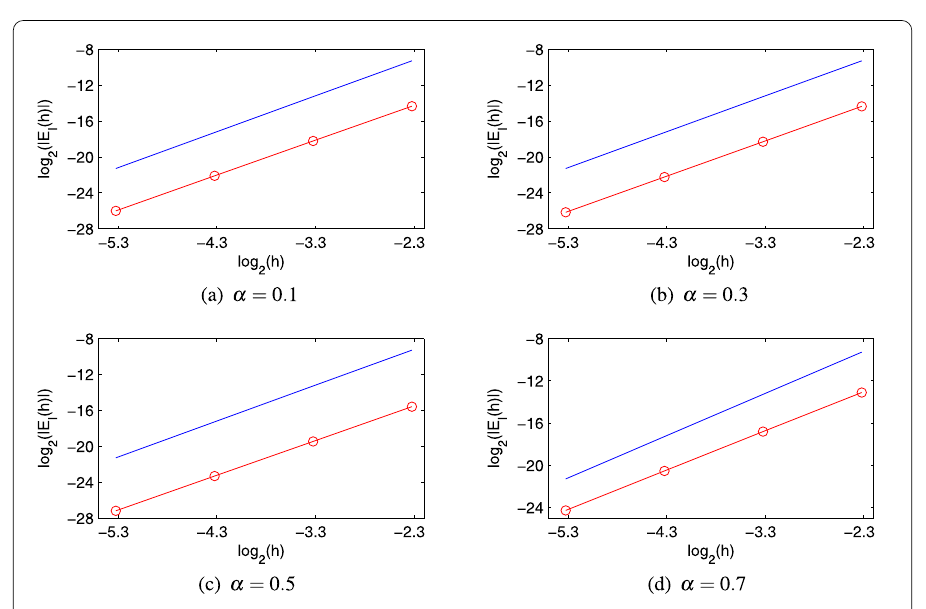
Figure 7 The experimentally determined orders of convergence for algorithm I at t = 1 for (31) with ν = 3.45 ( y ( t ) is not sufficiently smooth)